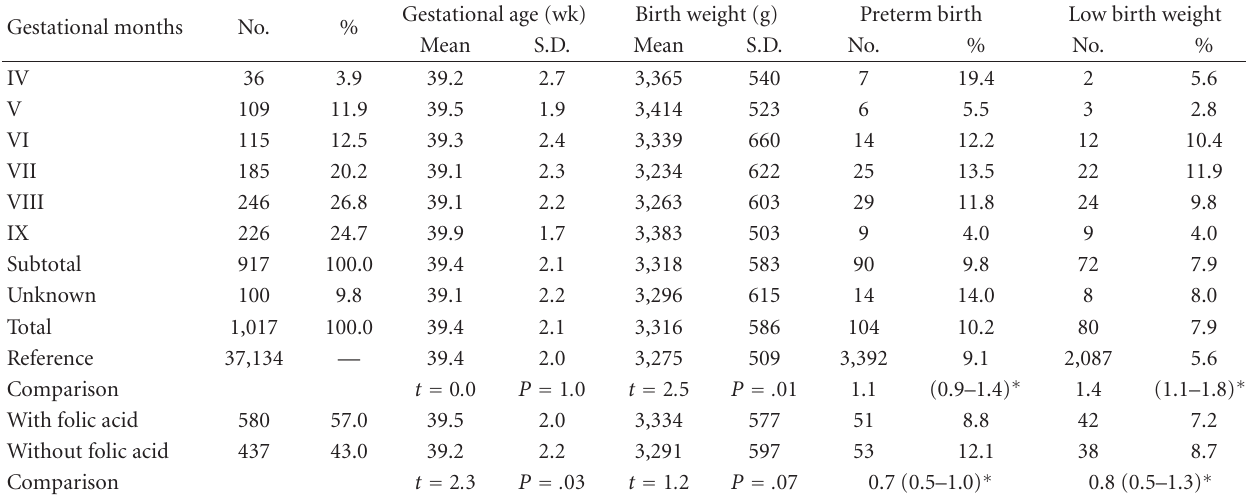
Table 2: Onset (diagnosis) of pregnant women with pre-eclampsia according to gestational month and their birth